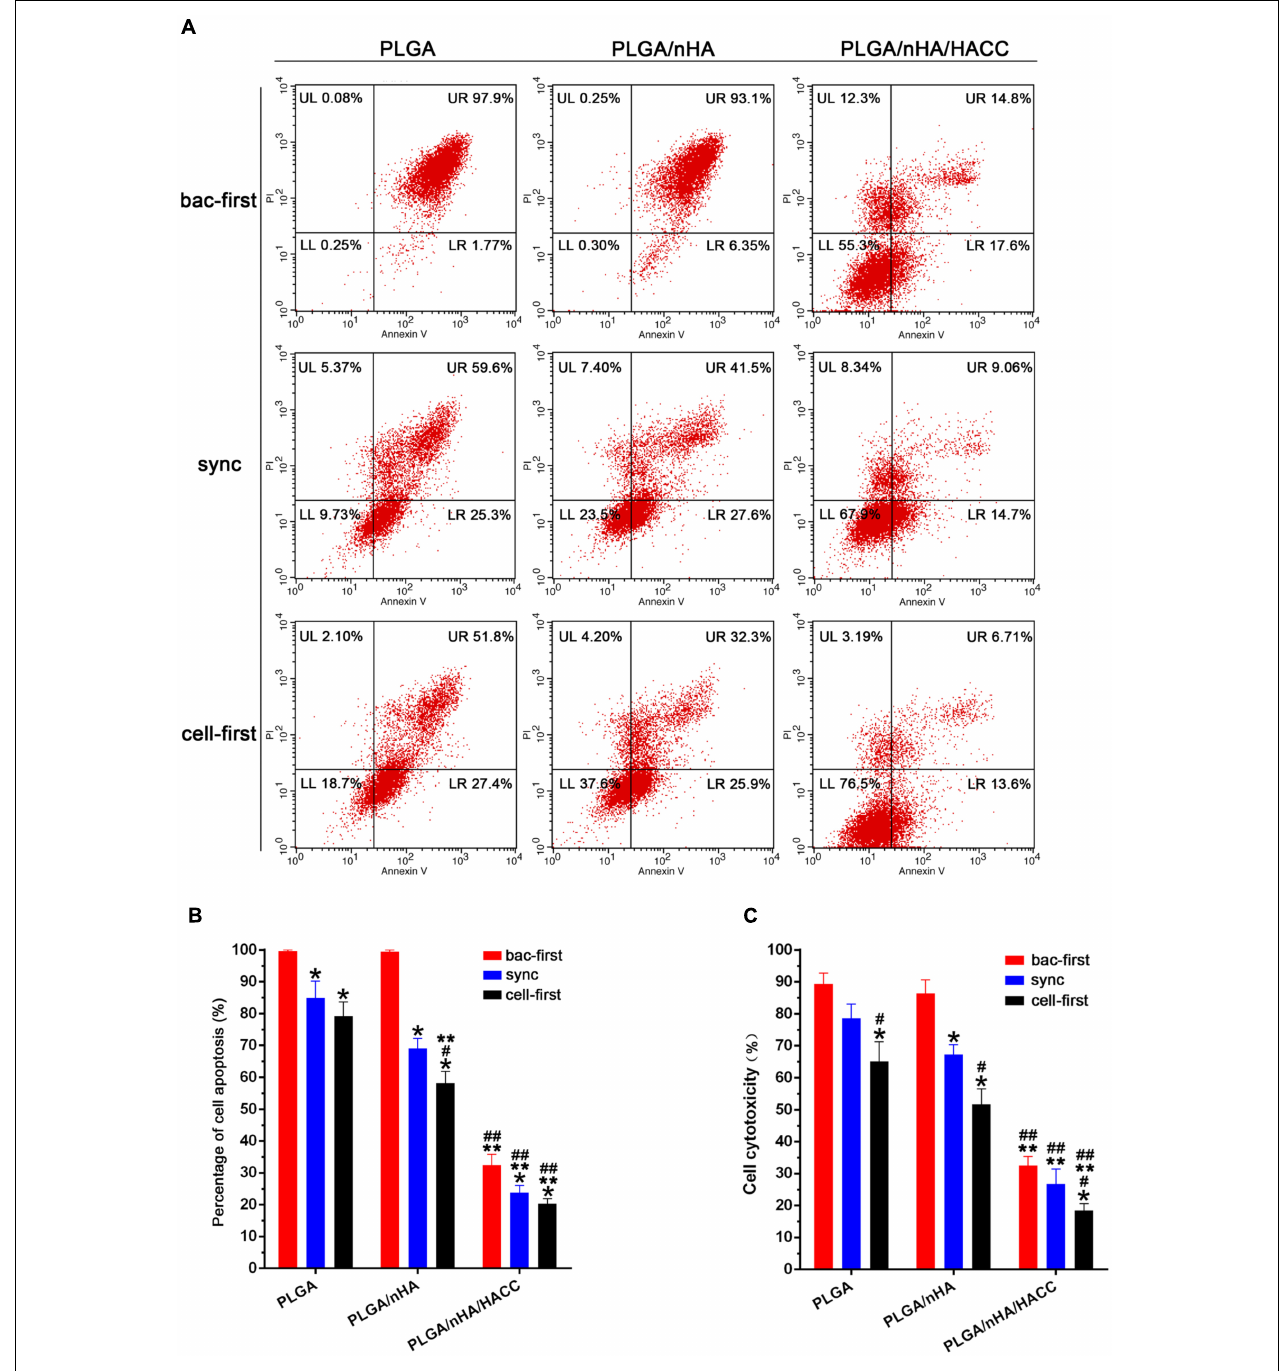
FIGURE 6 | Analysis of cytotoxicity on different materials surfaces with different co-cultured systems. (A,B) Cell apoptosis assay with flow cytometry. (C) Cytotoxicity assessed by the release of LDH into the supernatant. ∗ p < 0.05 compared with bac-first group on the same surface. # p < 0.05 compared with sync group on the same surface. ∗∗ p < 0.05 compared with PLGA group in the same co-cultured system. ## p < 0.05 compared with PLGA/nHA group in the same co-cultured system.